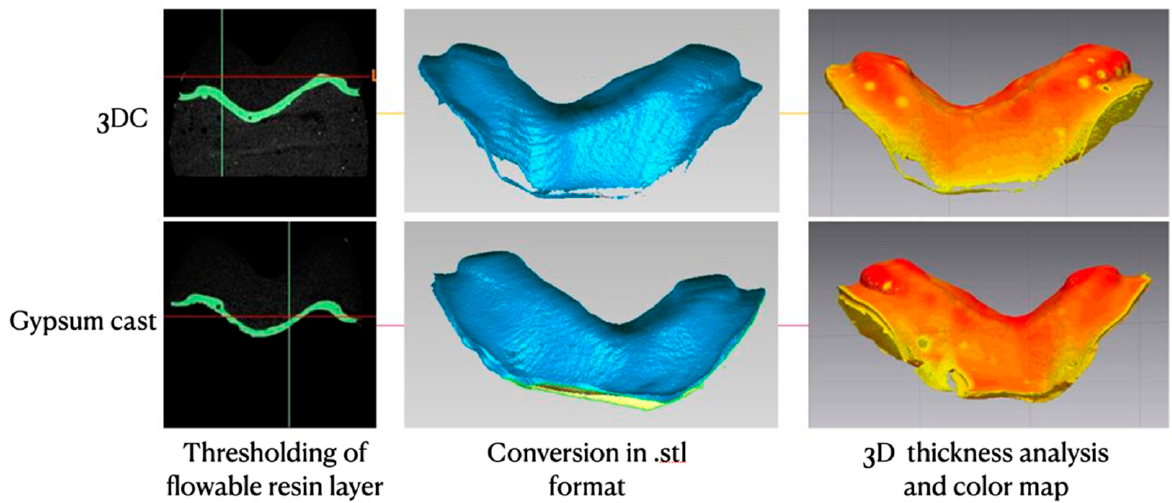
Figure 3. Same sample shown in Figure 2 interfacial analysis on 3DC and gypsum cast. Color map on the right of the picture represents cement thickness, scaling from yellow (30 µ m) to red (300 µ m) for visual representation.